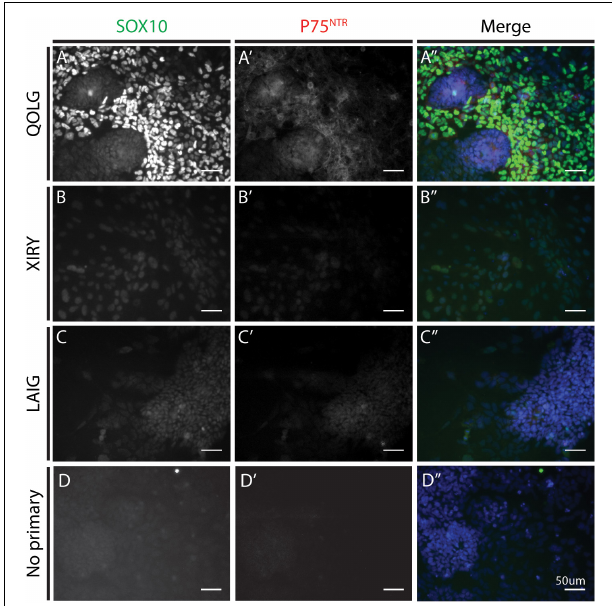
FIGURE 5 | BBS10 mutant cells express lower levels of SOX10 and P75NTR after neural crest induction. Immunostaining for the neural crest markers SOX10 (A–C) and P75NTR (A’–C’) . Control QOLG (A) cells had high levels of SOX10 and P75NTR. BBS10 mutant cells [XIRY (B) and LAIG (C) ] had significantly lower levels of both markers. Merge with DNA dye Hoechst (A”–C”) . No positive staining was observed in the no primary control for SOX10 or P75NTR (D–D”) . Scale bars = 50 µ